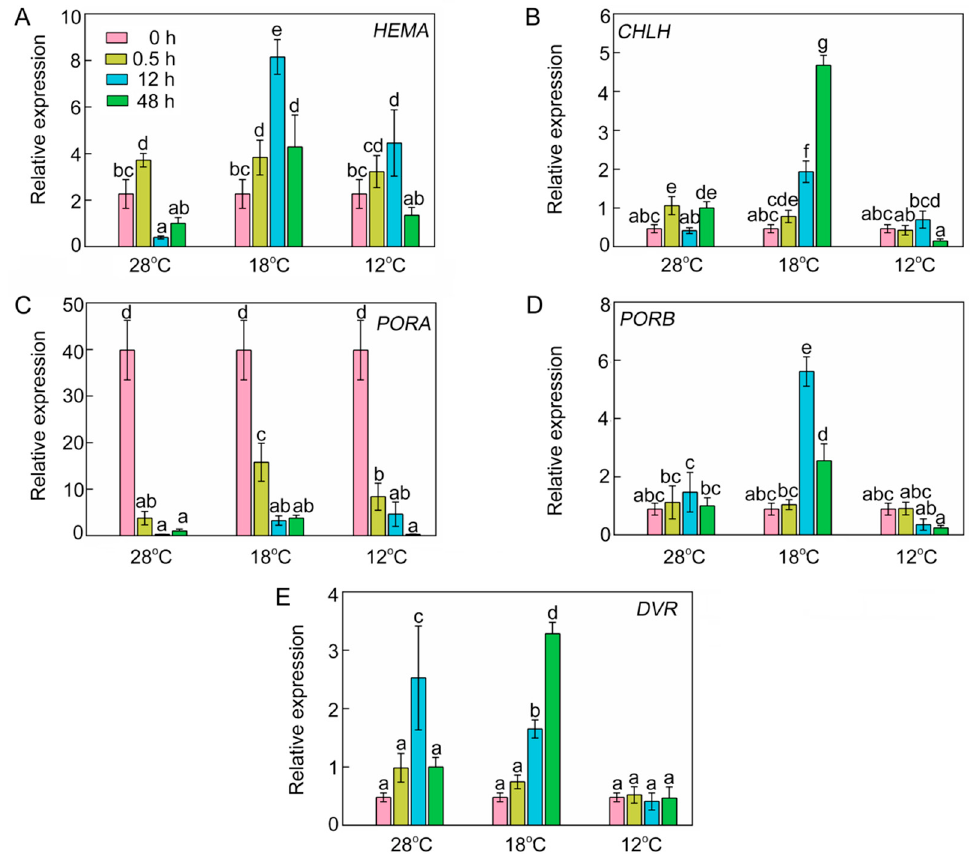
Figure 5. E ff ect of chilling stress on relative expression of chlorophyll biosynthetic genes HEMA ( A ), CHLH ( B ), PORA ( C ), PORB ( D ), and DVR ( E ). The expression levels of genes at 28 ◦ C after 48 h of light exposure were set to 1. OsACTIN1 was used as an internal standard. Values are means ± SD from three independent biological replicates. Di ff erent letters indicate significant di ff erences according to Duncan’s multiple range tests ( p < 0.05